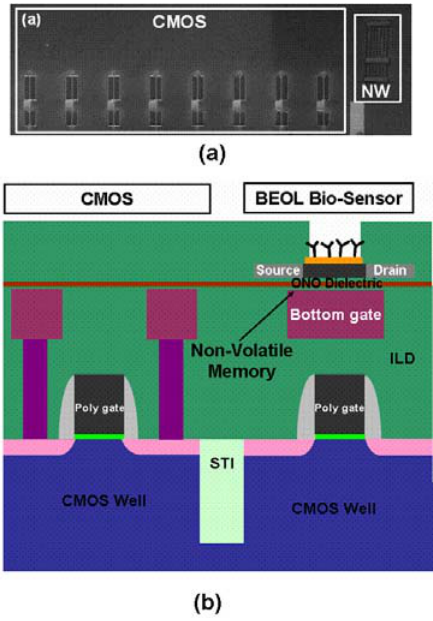
Figure 1. ( a ) Top-View SEM image of the nanowire and CMOS homogenous integration; ( b ) Cross-sectional schematic diagram of the hybrid technology with CMOS devices and biosensor embedded with memory functionality.